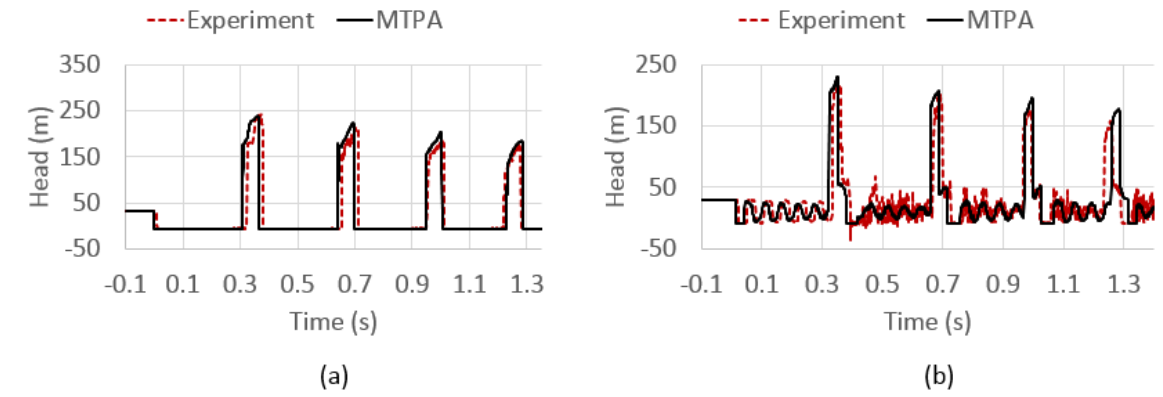
Figure 10. Cavity size evolution captured by CFD (Warda et al. [23]) .